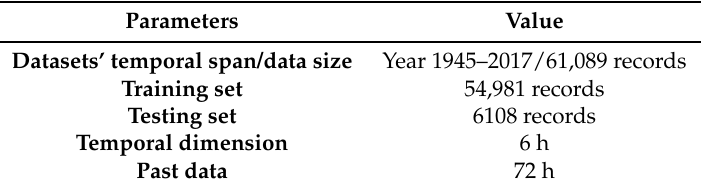
Table 1. The detailed experiment dataset.